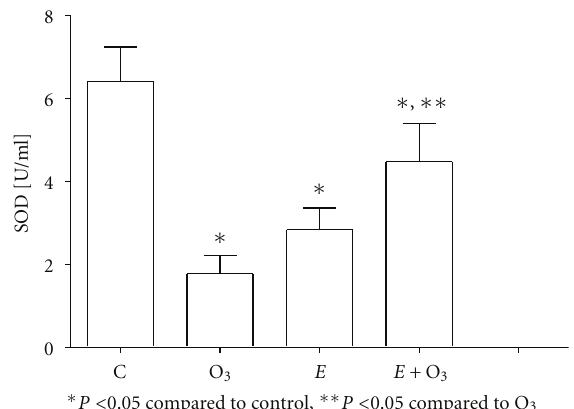
Figure 5: Plasma total superoxide dismutase (SOD) activity at week 2. Ozone (O 3 , 0.5 ppm 4 hours/day) exposure and exercise ( E , 90 min per day) significantly decreased plasma SOD activity. Exercise partially blocked O 3 e ff ects. Data were analyzed using the one-way ANOVA test and Tukey’s multiple comparison test post hoc . Data are shown as the mean ± standard error of mean ( n = 6 per